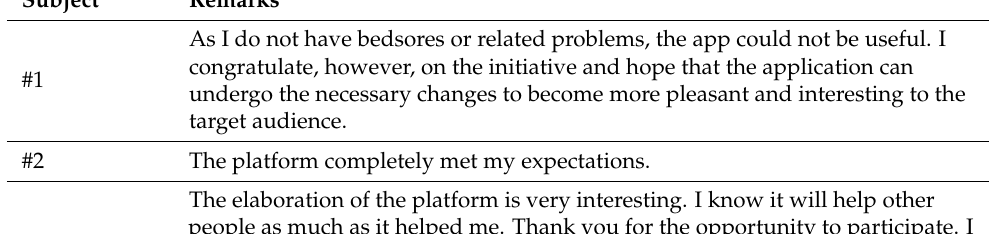
Figure 10. Collaborative Practices Carried Out in ColaborAtiva.